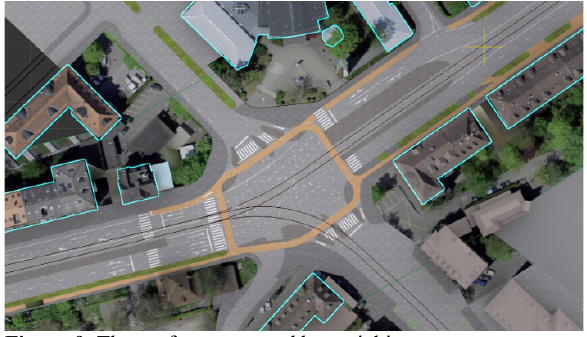
Figure 9. The roofs are textured by aerial